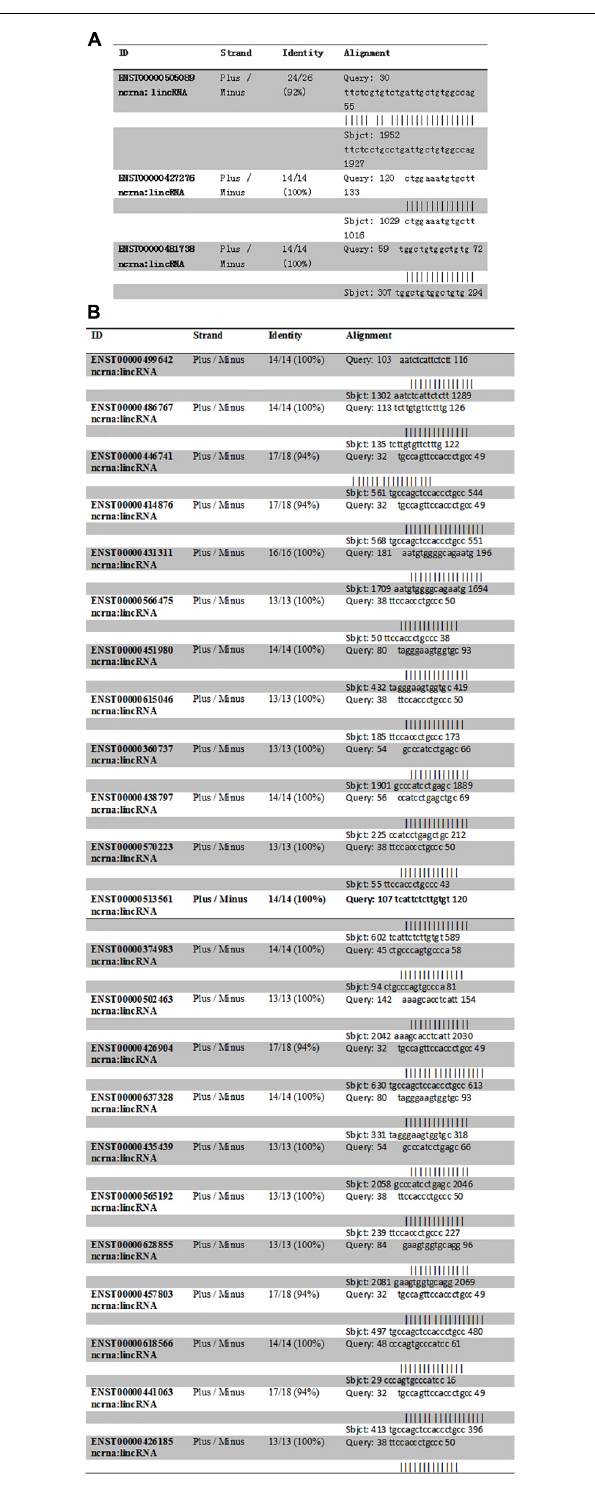
FIGURE 7 | Predicted lncRNA binding sites in DAB1 rs17115303 and PTPRT rs6030462. (A,B) Three lncRNAs were predicted to bind DAB1 rs17115303 (A) , and 23 lncRNAs were predicted to bind PTPRT rs6030462 (B) . In both cases, the lncRNAs were presumed to bind the transcriptional intron and not the DNA strand. lncRNA, long non-coding